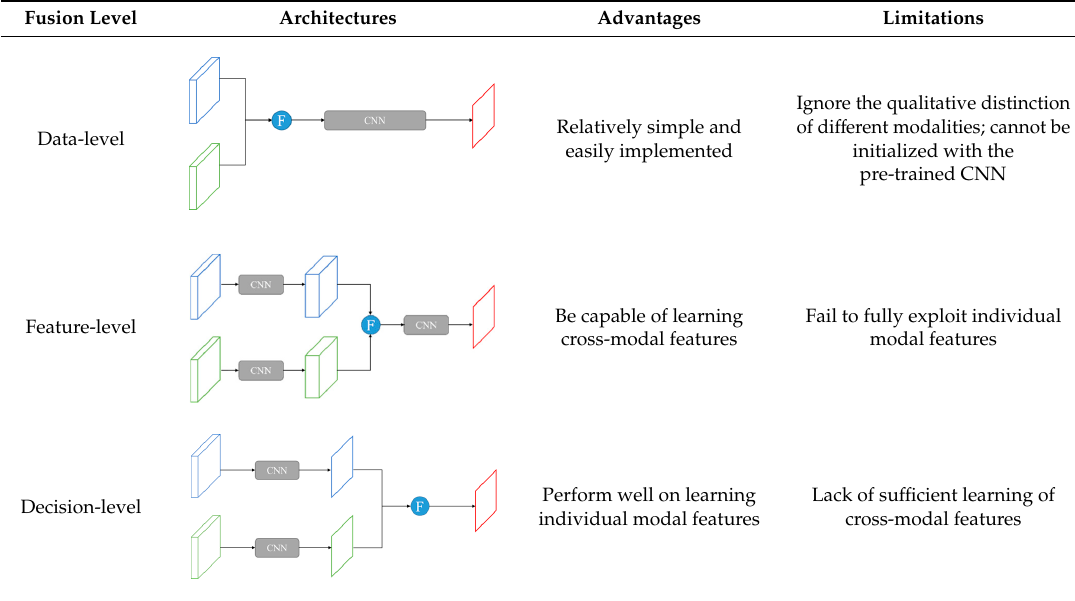
Table 1. Current DL-based fusion methods.